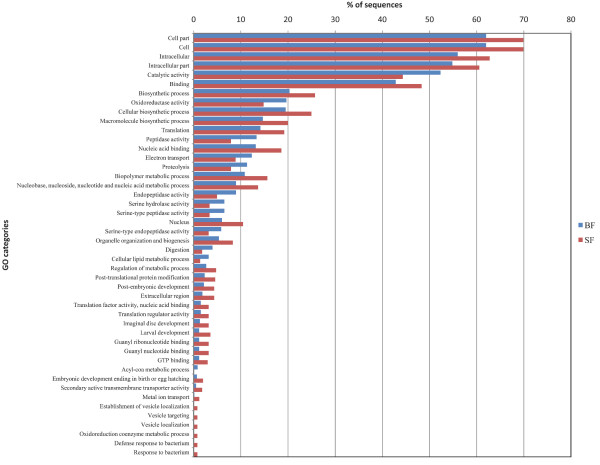
Statistical comparison of GO terms assigned to UTs from SF and BF libraries. The figure shows comparison of GO terms assigned to annotated UTs from SF and BF libraries based on Fisher's exact test. Only significantly altered (P < 0.05) GO terms are shown here. Other details are provided in Additional file 3. Note that individual GO terms can be assigned to multiple UTs and one UT can have multiple GO terms.